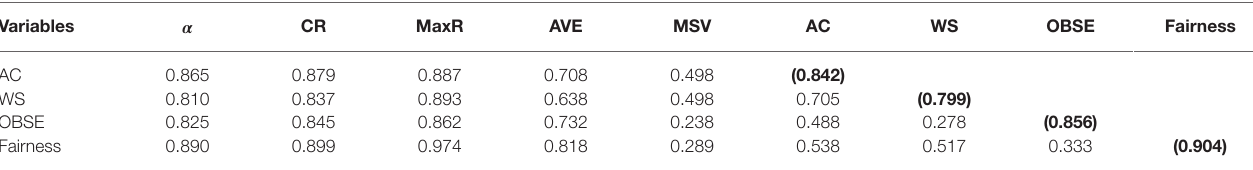
TABLE 2 | Reliability, validity, goodness of fit indices and inter-correlations among the study variables in the model.